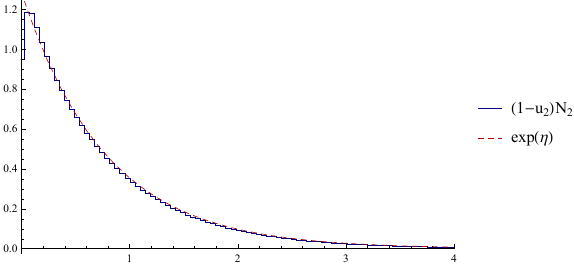
Figure 1: The densities of (1 − u 2 ) N 2 of model P 1 and an exponential distribution with parameter η